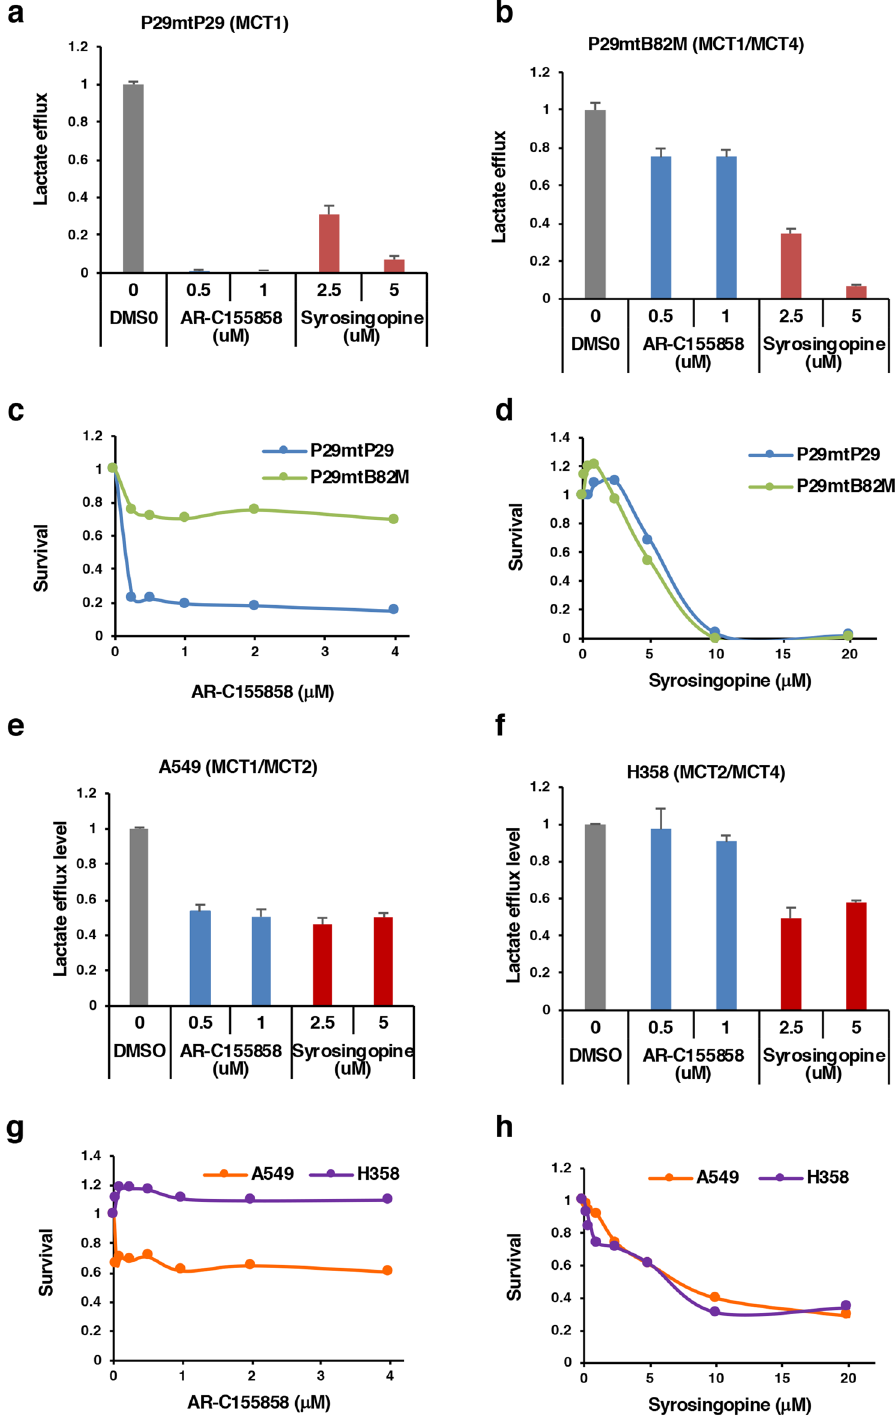
Figure 8. Inhibition of P29 cybrid cell and NSCLC cell growth by MCT inhibitors. ( a , b ) Effect of AR-C155858 and syrosingopine on lactate efflux in P29mtP29 and P29mtB82M cells. ( c , d ) Effect of AR-C155858 and syrosingopine on survival of P29mtP29 and P29mtB82M cells. ( e , f ) Effect of AR-C155858 and syrosingopine on lactate efflux in A549 and H358 cells. ( g , h ) Effect of AR-C155858 and syrosingopine on survival of A549 and H358 cells. Cell survival was determined by WST assay. Each point represents the mean of triplicate experimental